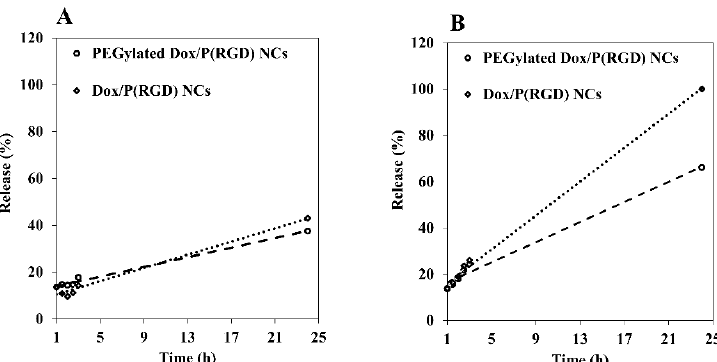
Figure 6. Relative release of non-PEGylated (dotted line) vs. PEGylated (dashed line) Dox/P(RGD) NCs in ( A ) PBS and ( B ) human serum over a 24 h incubation period at 30 °C.